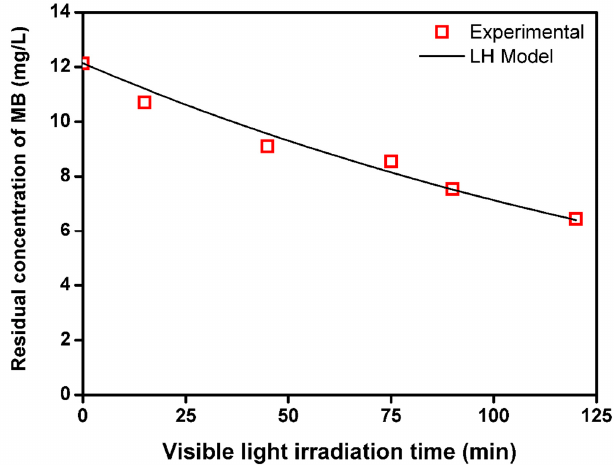
Figure 4. Experimental and L–H model fitting. Experimental conditions: [MB] o = 20 mg/L, I = 60 mW/cm 2 , pH = 6, [TiO 2 ] = 0.75 g/L. I = 60 mW / cm 2 , pH = 6, [TiO 2 ] = 0.75 g / Table 2. Kinetic constant values.